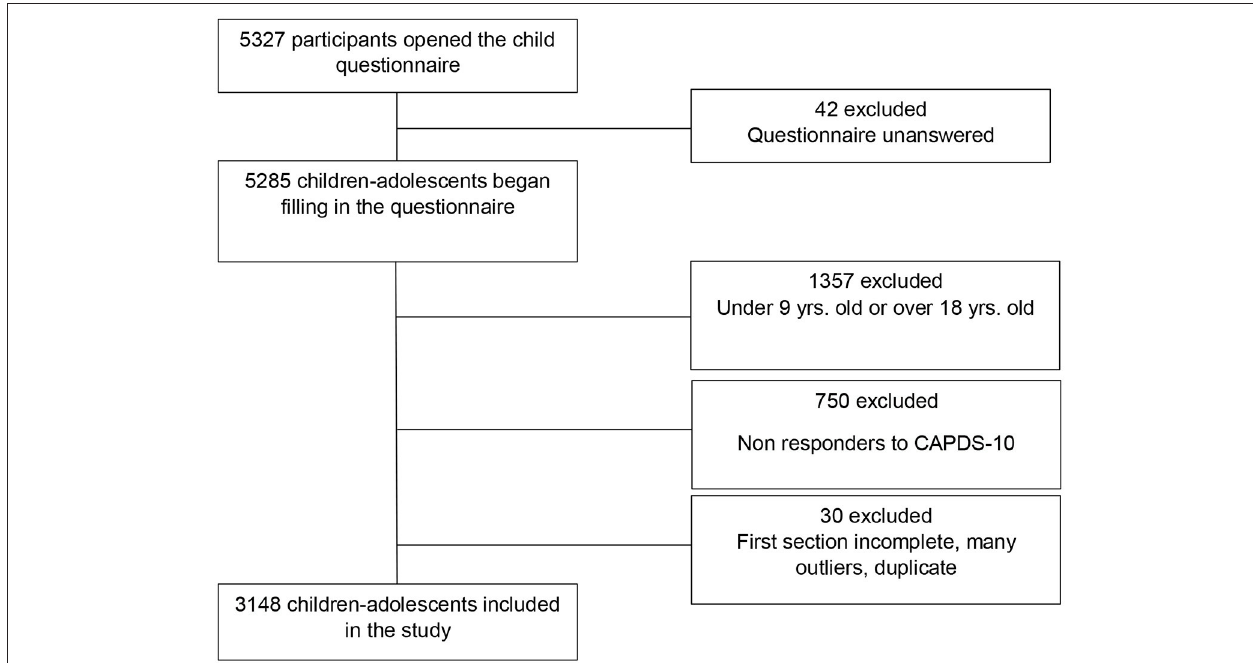
FIGURE 1 | Flow chart CONFEADO study, France,